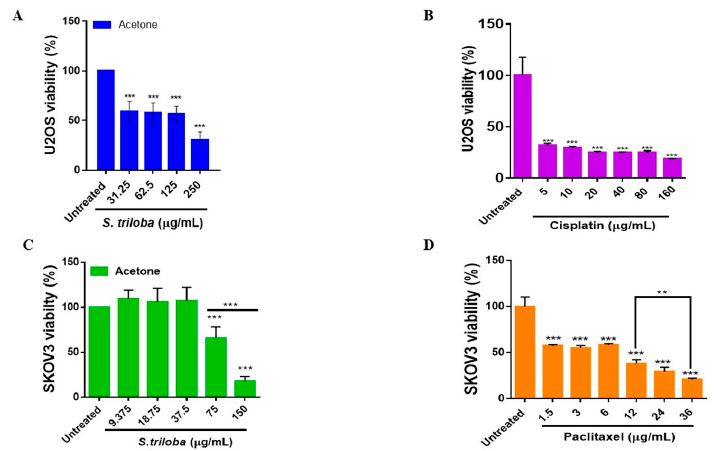
Figure 1. S. triloba acetone extract significantly reduces U2OS and SKOV3 cell viability. ( A ) U2OS cell viability after 48 h exposure to S. triloba acetone. The acetone extract significantly reduced U2OS cell viability at all tested concentrations. ( B ) U2OS cell viability was significantly reduced by more than 50% after incubation with cisplatin (48 h) at all examined concentrations; cisplatin served as a positive control for U2OS cells. ( C ) SKOV3 cell viability was significantly reduced when incubated (48 h) with S. triloba acetone extract at both 75 µg/mL and 150 µg/mL concentrations. A sharp decline in SKOV3 cell viability (>50%) was observed at the 150 µg/mL concentration, and this reduction showed statistical significance when compared to the 75 µg/mL concentration. ( D ) Paclitaxel (PTX) served as a positive control for SKOV3 cells; significant reductions in SKOV3 cell viability at all tested concentrations were observed after incubation with PTX (48 h). Comparisons were made between the treated samples and respective untreated controls; results are representative of three independent experiments (*** p ≤ 0.001, ** p ≤ 0.01, * p ≤ 0.05). MTT data were used to determine IC 50 values by generating dose–response curves for respective treatments. All dose–response curves possessed a negative slope, indicating a reduction in cell viability as the extract concentration increased. IC 50 values obtained for U2OS were 30.210 ± 1.180 µg/mL (R 2 = 0.797) and 3.033 ± 1.189 µg/mL (R 2 = 0.919) for S.